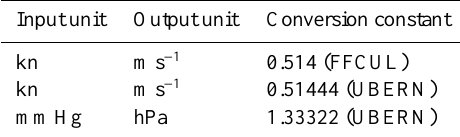
Table 4. Unit conversion constants